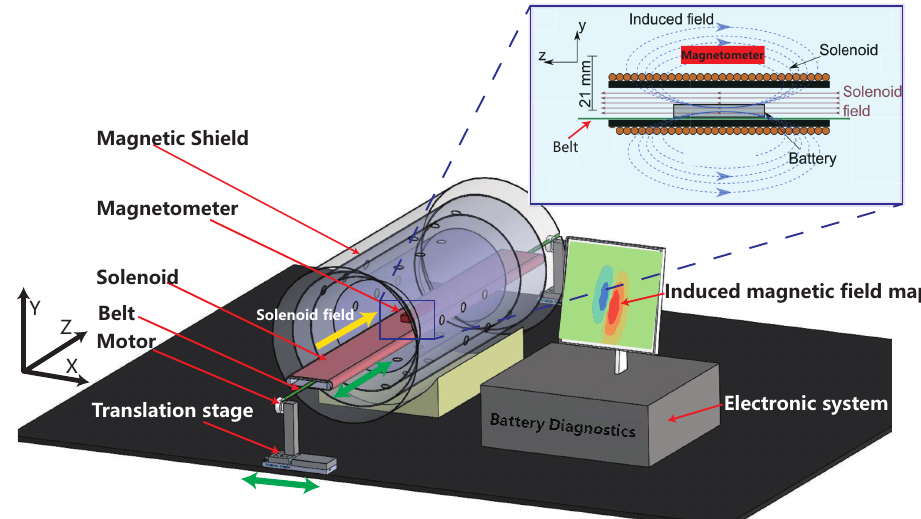
Figure 1. Experimental setup. A motor-driven conveyor belt moves the battery cell through a long solenoid, which can provide a constant background magnetic field. The magnetometer sensor is placed in the ultra-low-field region, above the solenoid, the solenoid is shown extending beyond the four-layer Twinleaf MS-2 magnetic shielding. The conveyor belt moves the battery back and forth along the z axis, while translation stages on each end move the entire belt with 0.1-mm precision along the x axis. (Inset) Side view of the experimental